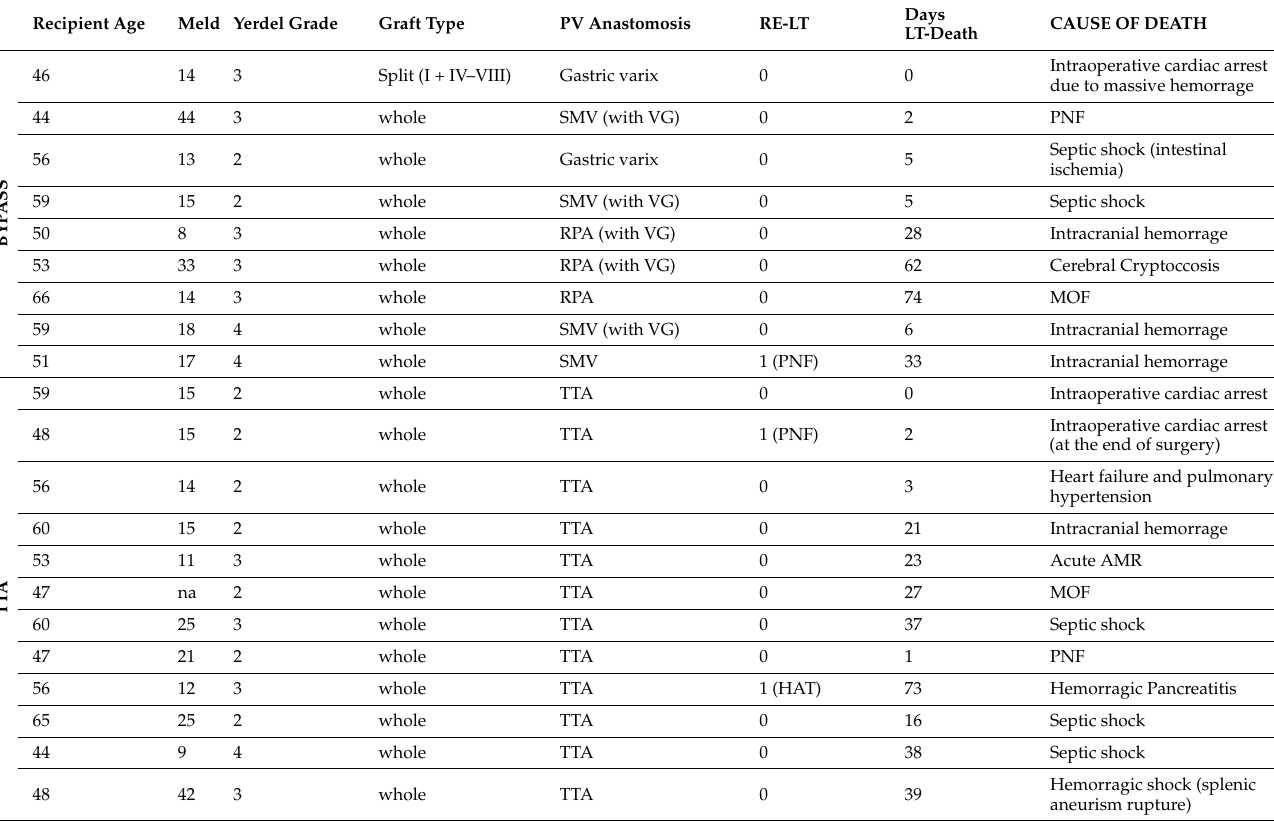
Table 4. Description of the main clinical and operative features of the recipients who died within 90 days with the main post-operative